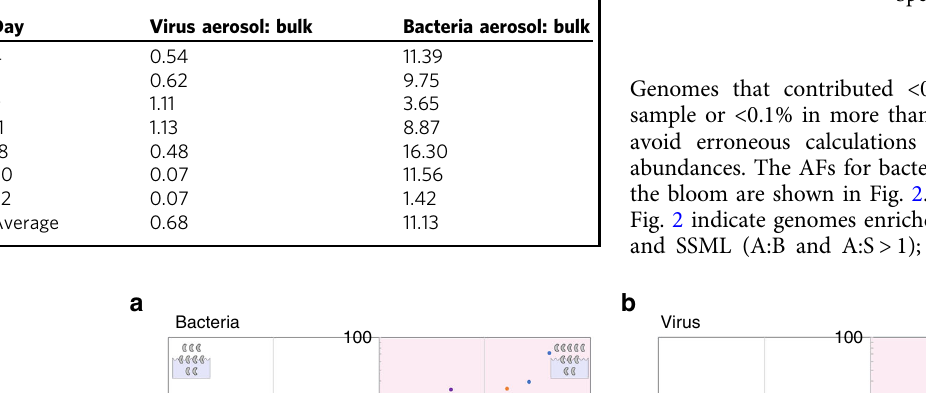
Table 2 The ratio of aerosol to bulk virus and